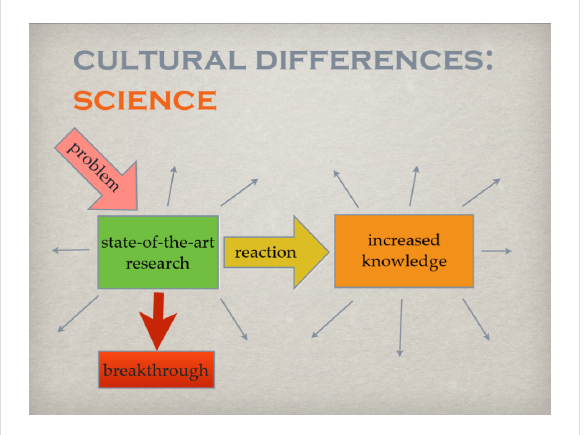
Figure 4: Achieving a breakthrough by following ideas off the main-